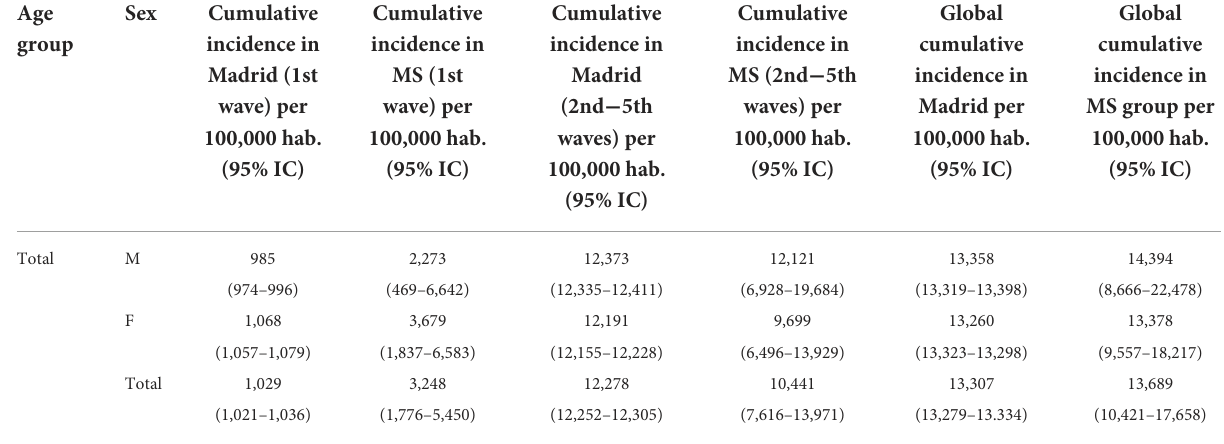
TABLE 2A Sex-adjusted cumulative incidences of COVID-19 in our MS cohort and in Madrid population during the first wave, during second to fifth waves, and global (first to fifth waves).